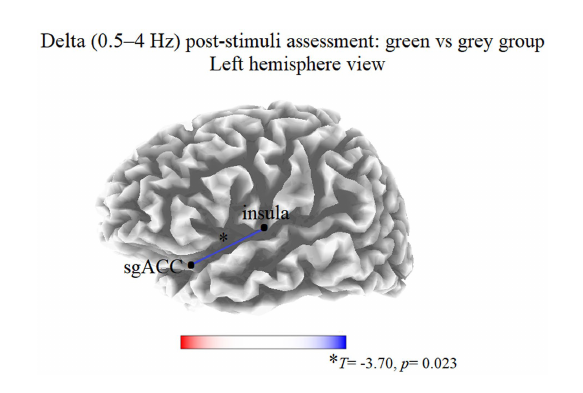
FIGURE 1 Results of the eLORETA functional connectivity between group comparison (green vs. gray) in the delta frequency band at T1. Blue lines indicate connections presenting a decrease of EEG functional connectivity. Red lines (not present) would indicate an increase of EEG functional connectivity. Threshold values ( T ) for statistical significance are reported at the bottom of the figure. sgACC, subgenual anterior cingulate